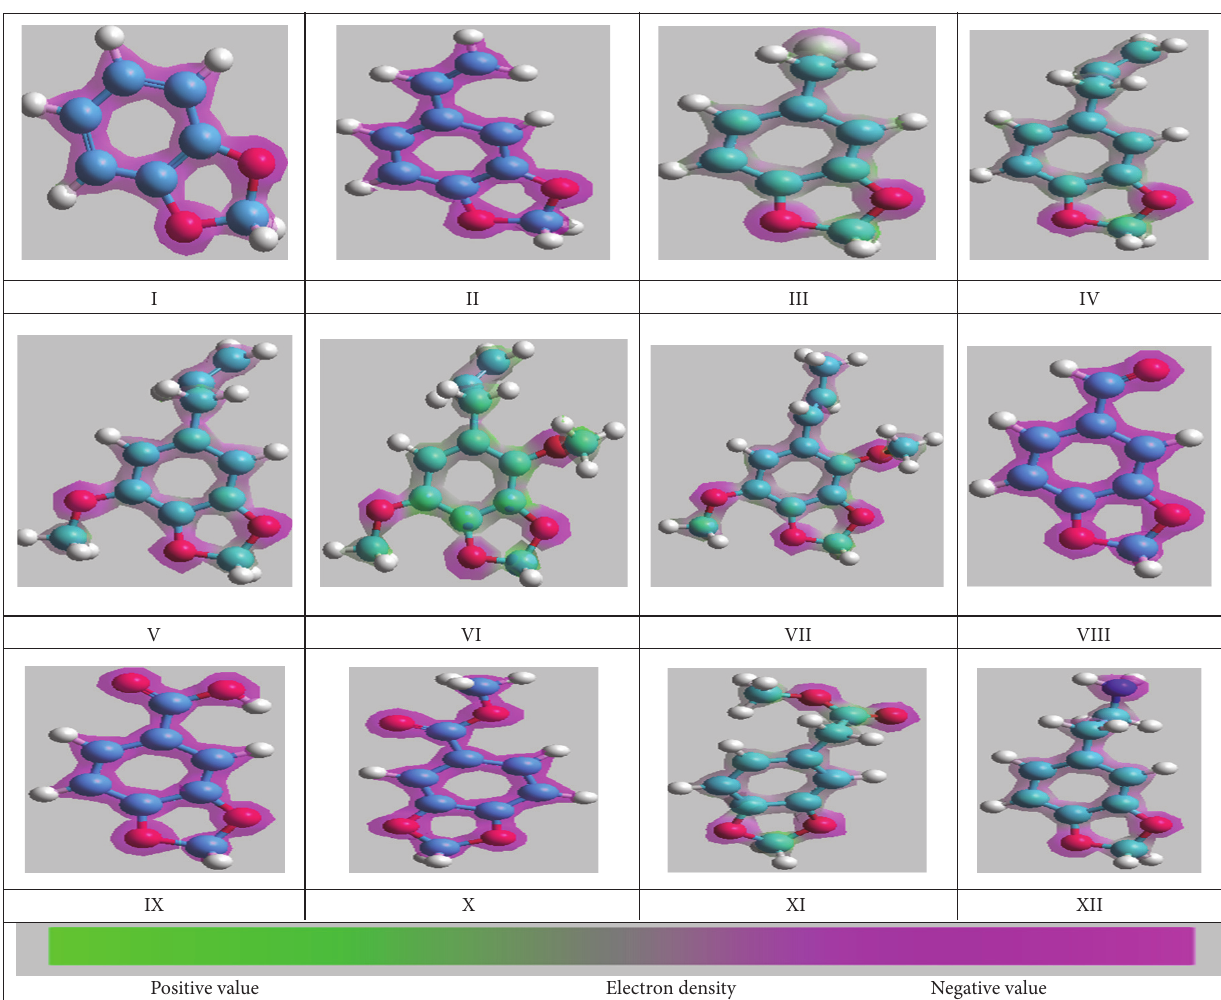
Figure 4: The total e’s density for the investigated 1,3-benzodioxole